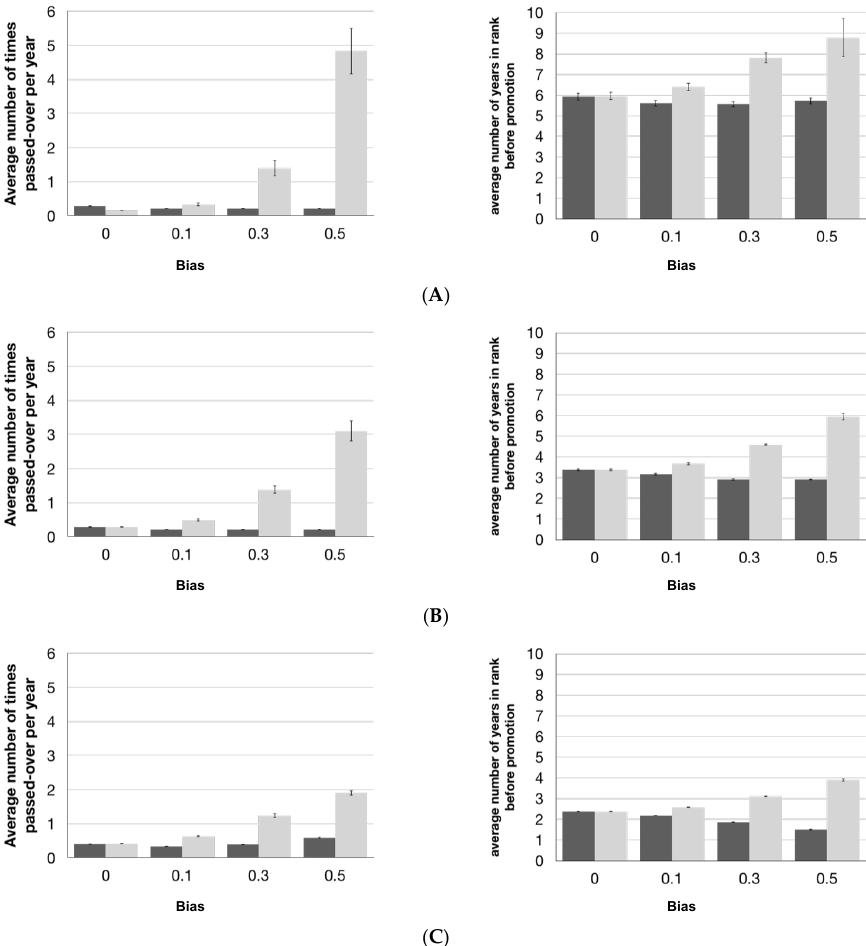
Figure 9. Average number of times passed-over (left column) and average number of years in rank (right column) for ( A ) VP level (top row), ( B ) manager level (middle row) and ( C ) entry level (bottom row) levels. In each chart, the dark bars represent simulation data for men, while the light bars represent simulation data for women. The number below each pair of bars represents the level of promotion bias.